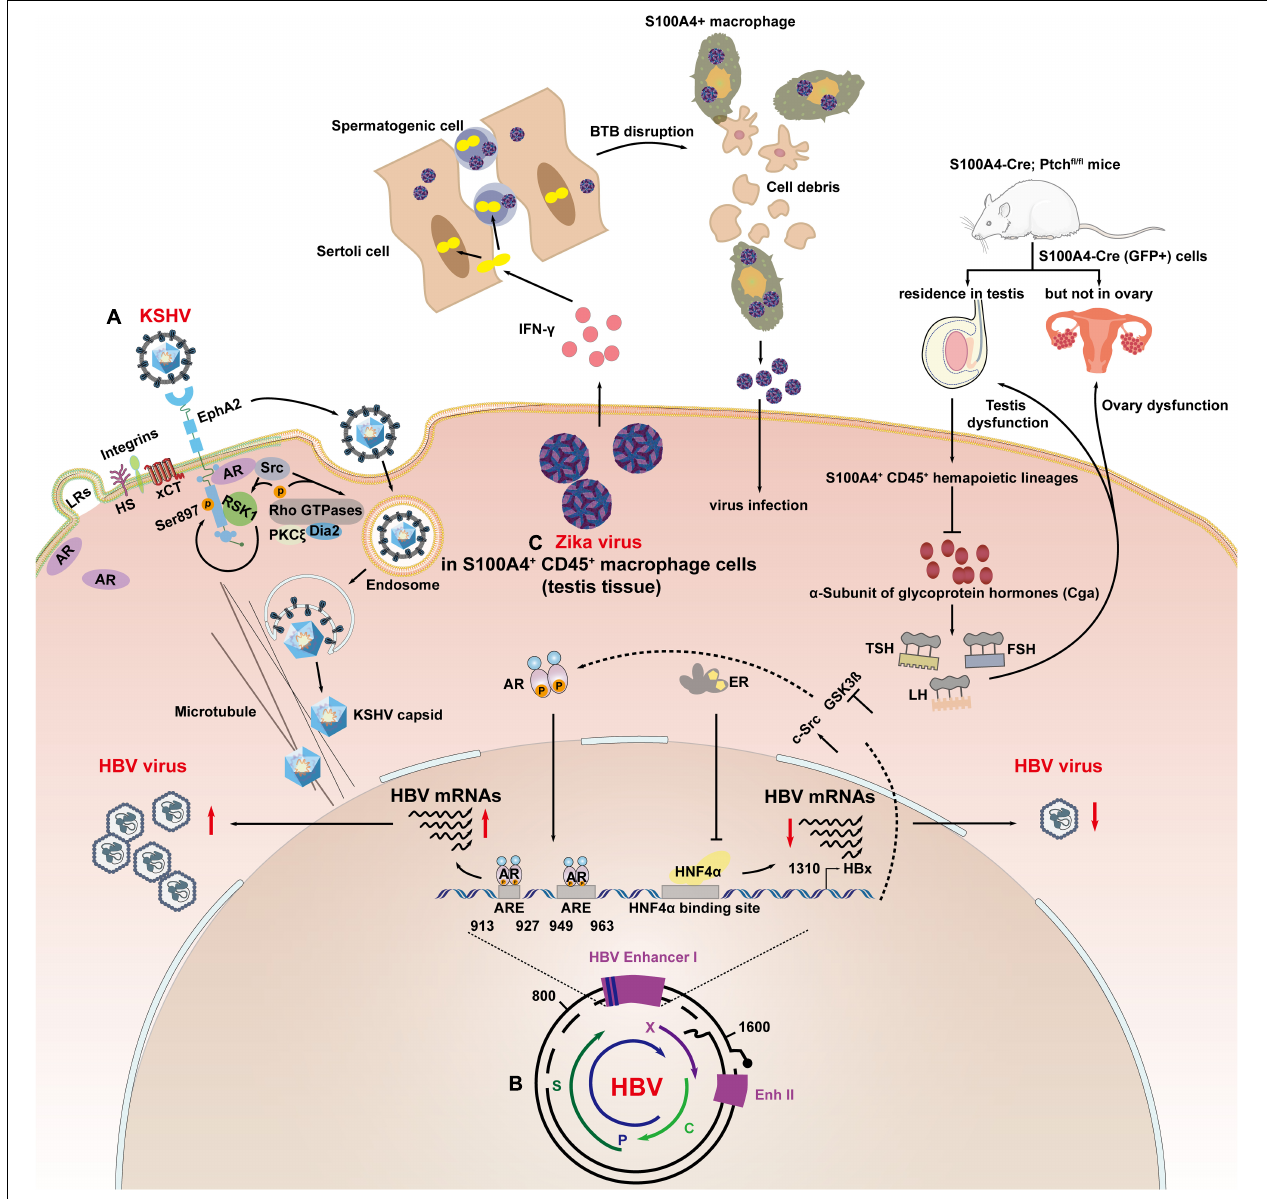
FIGURE 2 | Sex hormone signaling axis modulates viral infection at the viral entry, transcription and replication stages. (A) AR mediated recruitment of Src, which led to the activation of the kinase p90 RSK1, which led to Ser897 phosphorylation of EphA2. AR coordinated activation of the Src/RSK1/EphA2 Ser897 signal to accelerate endocytosis of KSHV. (B) Androgen pathway increased the transcription of HBV mRNAs through direct binding to ARE1 (913–927 bp) and ARE2 (949–963 bp) in HBV enhancer I. The HBx gene can also enhance AR activity by activating c-Src signaling pathways and inactivating GSK-3 β signaling pathways; ER- α binds to HNF-4 α , causing molecular chelation, which inhibited the DNA binding ability of HNF-4 α to HBV enhancer I, resulting in a decrease in enhancer I activity and HBV gene transcription. (C) ZIKV infection attracted S100A4 + macrophages to aggregate and differentiate into interferon- γ -expressing cells in the testis and secrete interferon- γ , increasing the permeability of the blood–testicular barrier (BTB), thereby facilitating the entry of ZIKV into the spermatogenic tubules; S100a4-Cre (GFP +) cells are expressed in the testis and rarely expressed in the interstitial tissue of the ovary. The interruption of the PTCH1 signaling